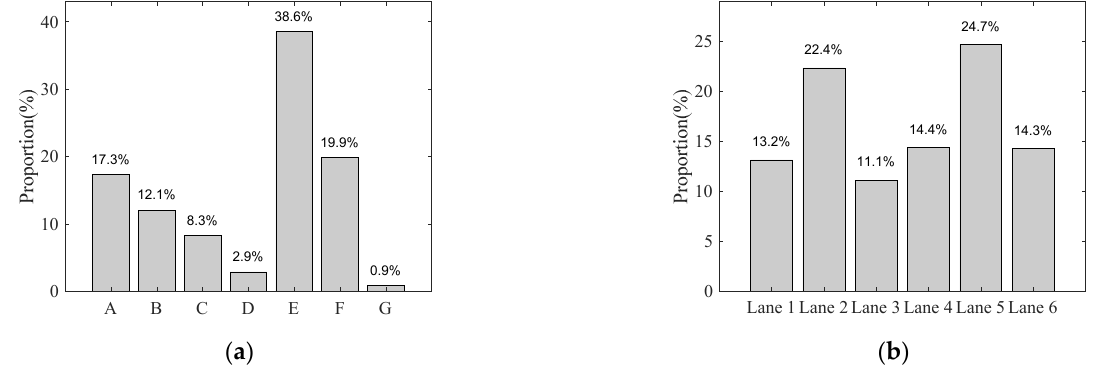
volume. Figure 3a shows the statistical proportions of the number of vehicles for different types, and Figure 3b shows the corresponding proportion in each lane.